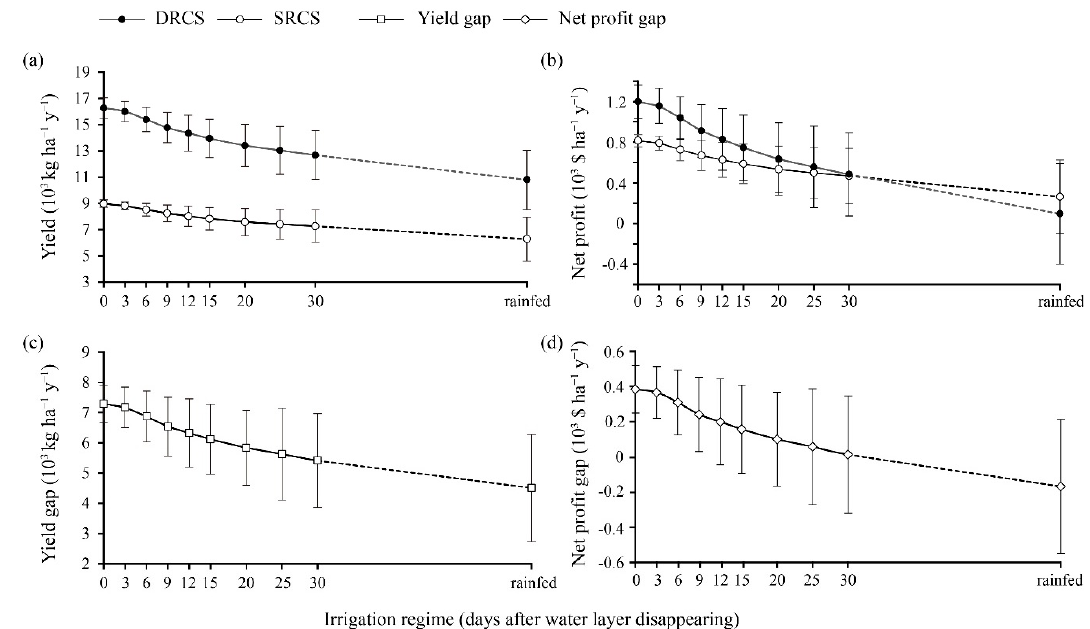
Figure 5. Rice grain yield (10 3 kg ha − 1 y − 1 ) ( a ) and net profit (10 3 $ ha − 1 y − 1 ) ( b ) for DRCS and SRCS at different irrigation regimes, including rainfed condition (i.e., no irrigation), during the growing season from 1981 to 2015. Note: Error bars indicate the standard deviations. ( c ) Rice grain yield gap between DRCS and SRCS. ( d ) Net profit gap between DRCS and SRCS.